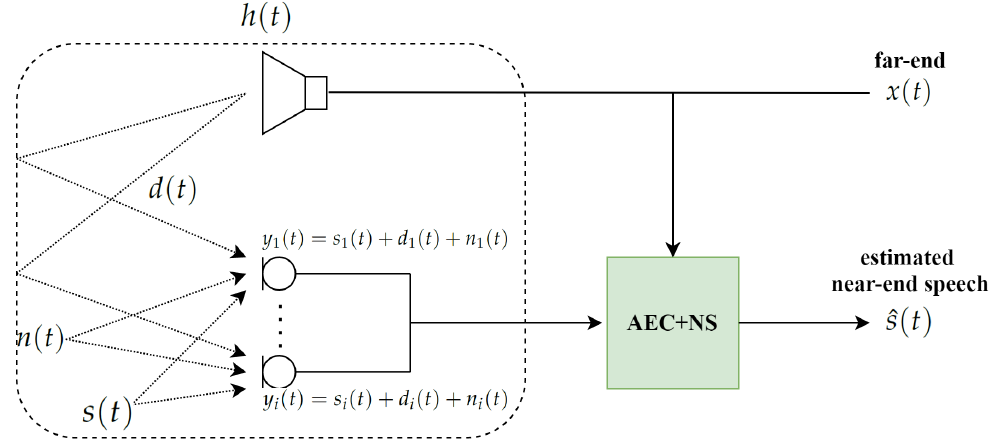
Figure 1. Block diagram of suppressing acoustic echo and background noise in the multi-channel scenario. AEC, acoustic echo cancellation; NS, noise